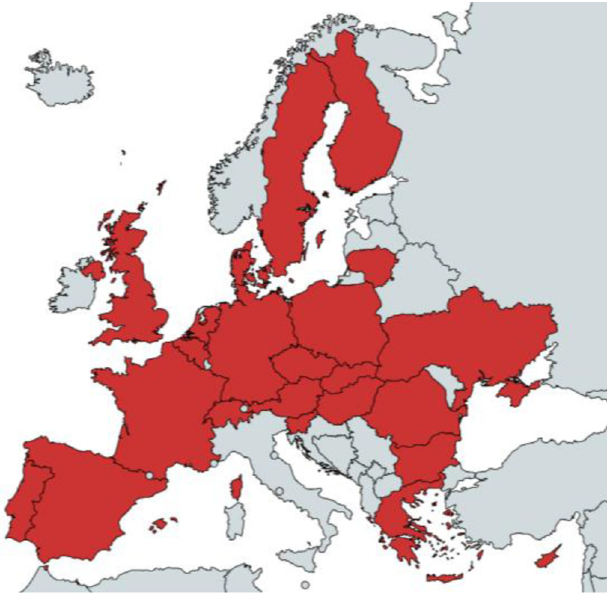
Fig. 1. Representation of countries involved in the joint